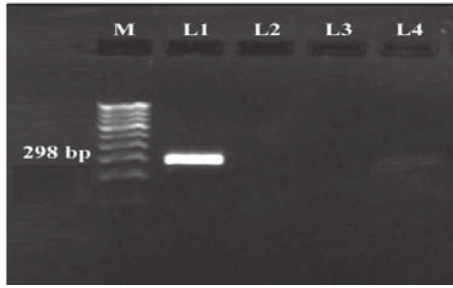
Fig. 1 Amplicons of H.